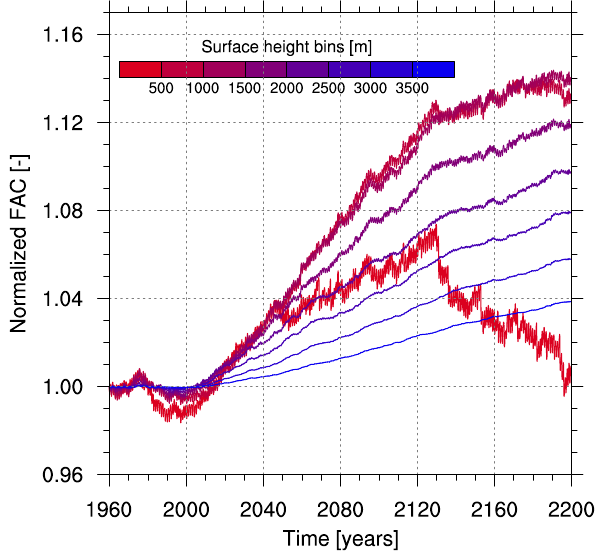
Figure 8. Temporal evolution of firn air content (FAC) in different surface height bins (line color) of the grounded ice sheet. The FAC is normalized using the value of 1 January 1960.